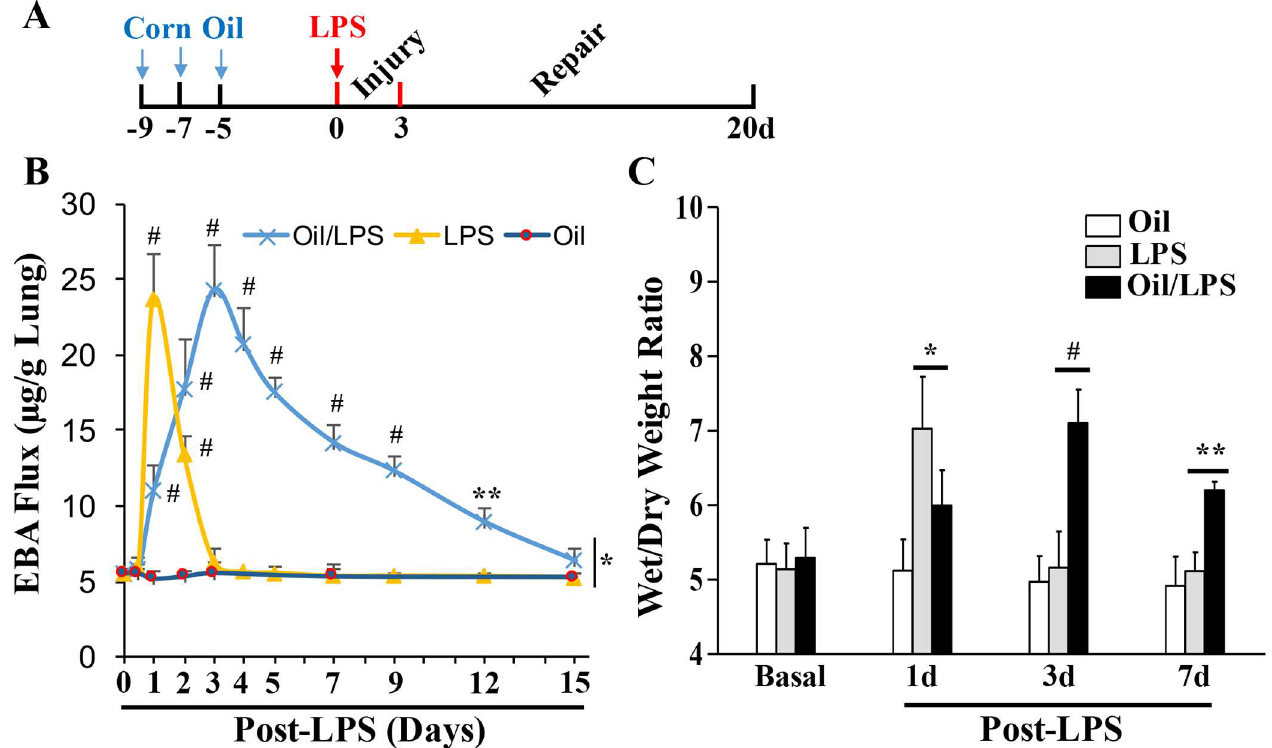
Fig 1. Extended course of lung vascularinjury and recoveryin corn oil/LPS-challenged mice. ( A ) The oil/LPS model: Corn oil was administered i.p. at 12ml/kg every 48h for 3 times. Five days after the last injectionof corn oil (i.e., waitingfor 5 days to avoid any potentialeffects from corn oil administration), the mice were challenged with. ( B ) Time course of lung vascular permeability assessedby EBA extravasation assay. The data demonstrated sustainedlung vascular leakinessin corn oil/LPS-challengedmice comparedto oil-free mice challengedwith LPS. * , P < 0.05. ** , P < 0.01; #, P < 0.001 versus basal with or without oil, respectively.Corn oil administration per se didn’t inducelung vascular injury. ( C ) The lung wet/dry weight ratio was determinedto assess pulmonaryedema. Oil-free mice exhibitedmarked lung edemaat 1 day post-LPS challenge and returnedto basal level at 3 days post-LPS. However,the mice pre-administered with corn oil exhibitedlung edema at 3 and 7 days post-LPS challenge. All data are expressedas mean ± SD (n = 4/group). * , P < 0.05; ** , P < 0.01; #, P < 0.001.